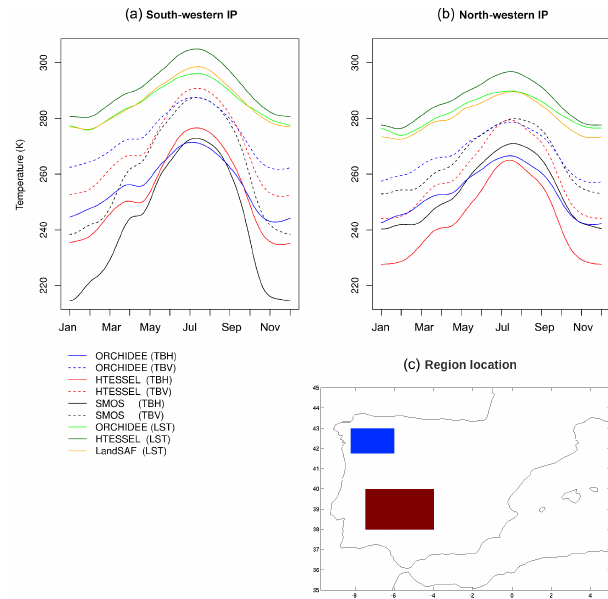
Figure 10. Smoothed annual cycle of TB SM , TB OR , and TB HT , as well as of the LST signals from ORCHIDEE, H-TESSEL, and LandSAF over south-western (a) and north-western (b) regions of the Iberian Peninsula, from 2010 to 2012. The TBH and TBV corre- spond to the horizontal and vertical polarizations, respectively. The regions’ location is shown in panel c: south-west (red) and north- west